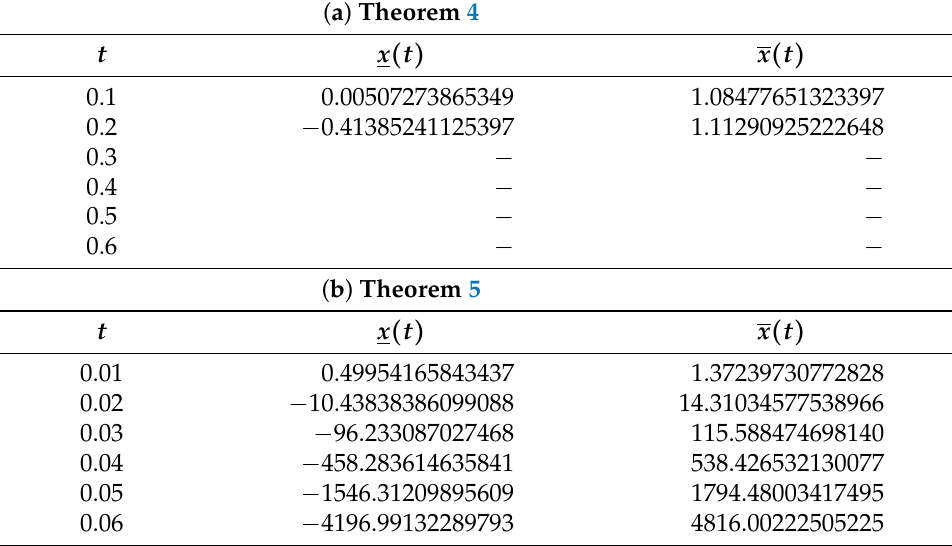
Table 5. Comparison of Theorems 4 and 5 for the example (40) with